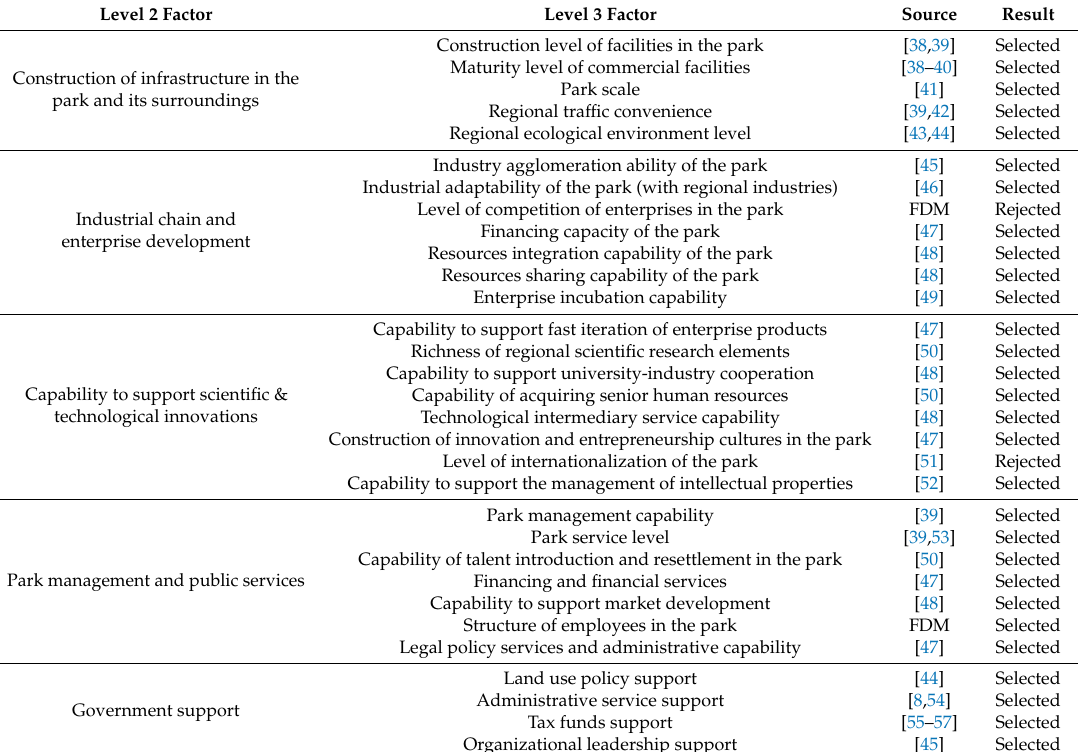
Table 7. Related influencing